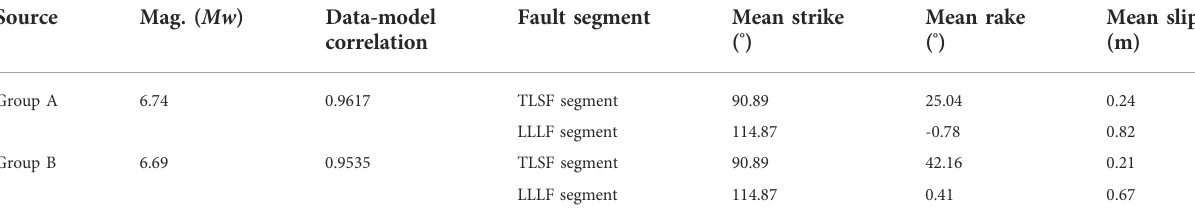
TABLE 3 Inversion results of the 2022 Menyuan earthquake from different data set groups.